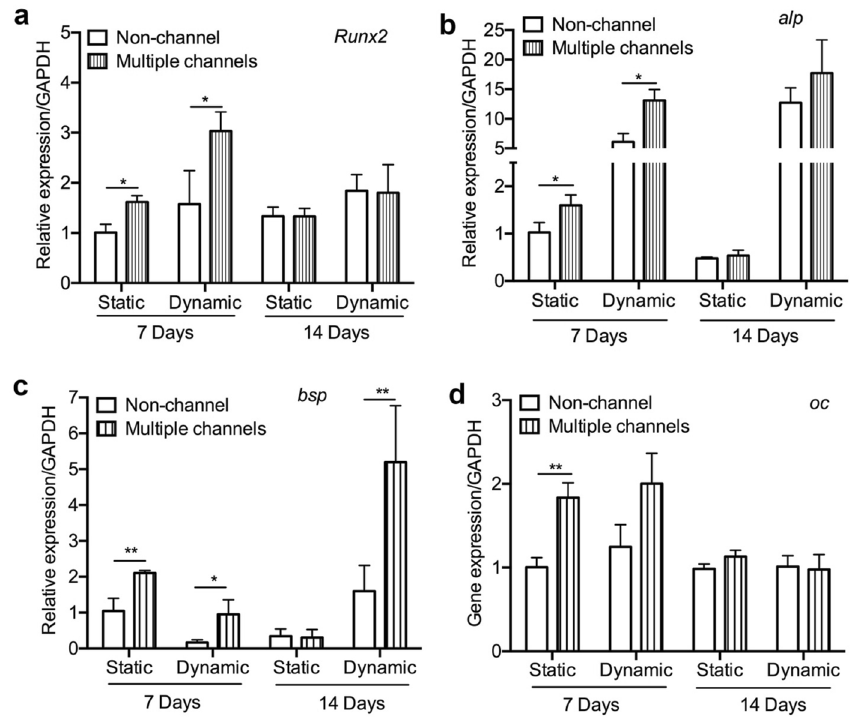
Figure 3. Osteogenic gene expression: osteogenic gene expression of hBMSCs on the β-TCP scaffolds under the static and dynamic conditions after 7 and 14 days. (n = 3, * p < 0.05, ** p <